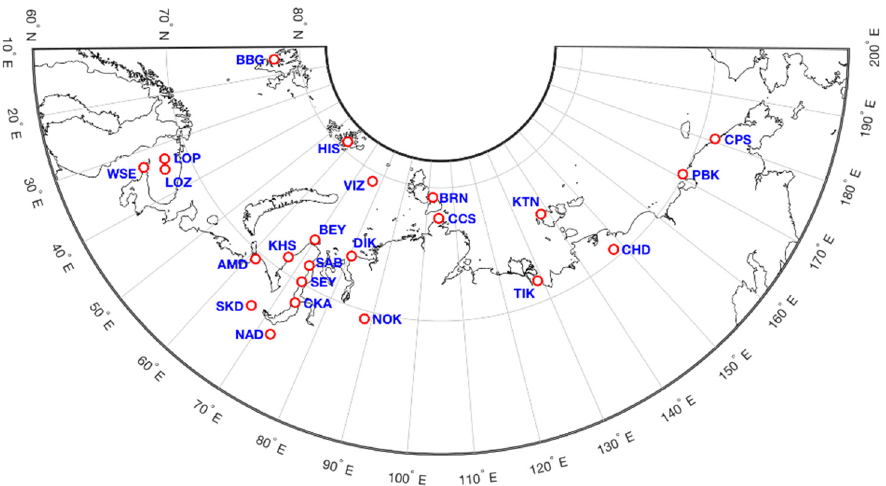
Figure 1. Stations in the Arctic zone of the Russian Federation monitoring geomagnetic field varia- tions.